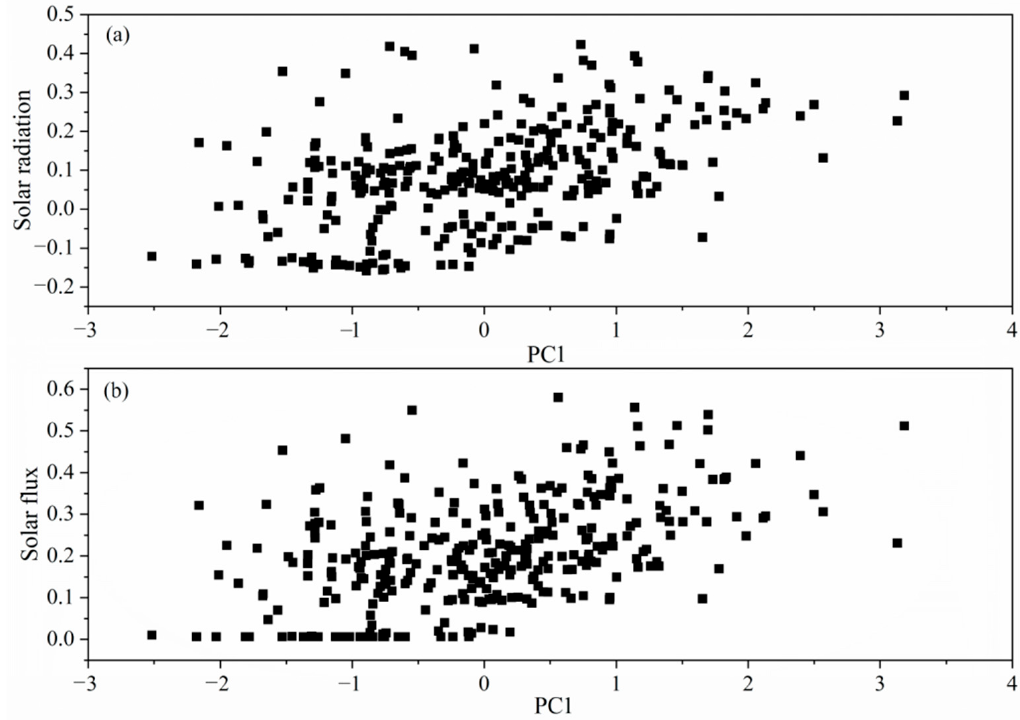
Figure 11. PC1 and the ( a ) solar radiation and ( b ) solar flux indices scatter plot.